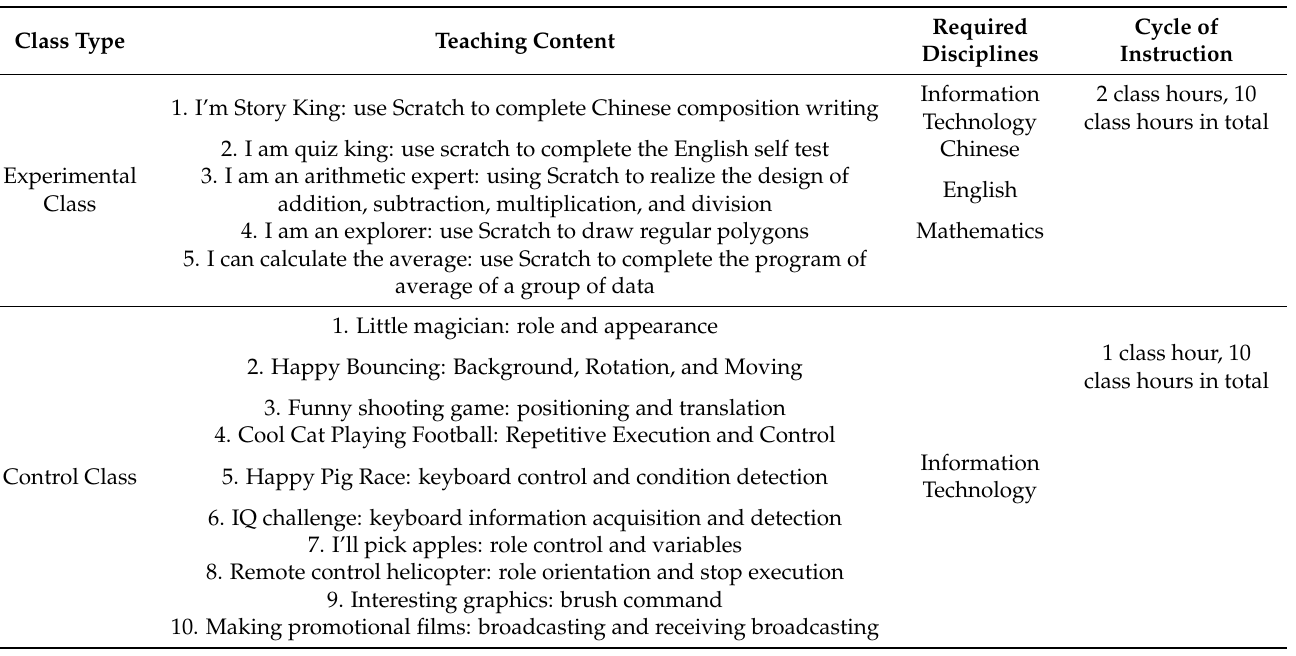
Table 1 for more detail. The teaching for the control class was based on Scratch curriculum content for traditional programming design and teaching. The CTt and Dr. Scratch were then selected as the evaluation tools for the practical effects. Table 1. Teaching content of experimental class and control